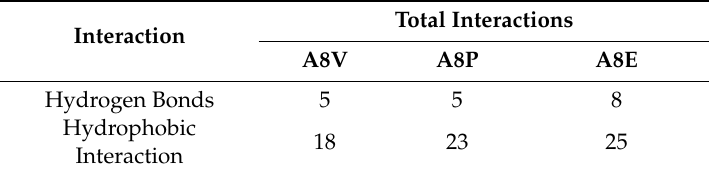
Figure 1. Superposition of global structure of wt-L2 (blue) with A8V (orange), A8P (purple) and A8E (green). Shown in the foreground is the anchoring of the N -terminal tail towards the global structure of the lipases. The anchoring is due to the formation of molecular interactions upon substitution at position 8. Table 3. The total number of hydrogen bonds and hydrophobic interactions at the N -terminal tail of wt-L2 mutant lipases.